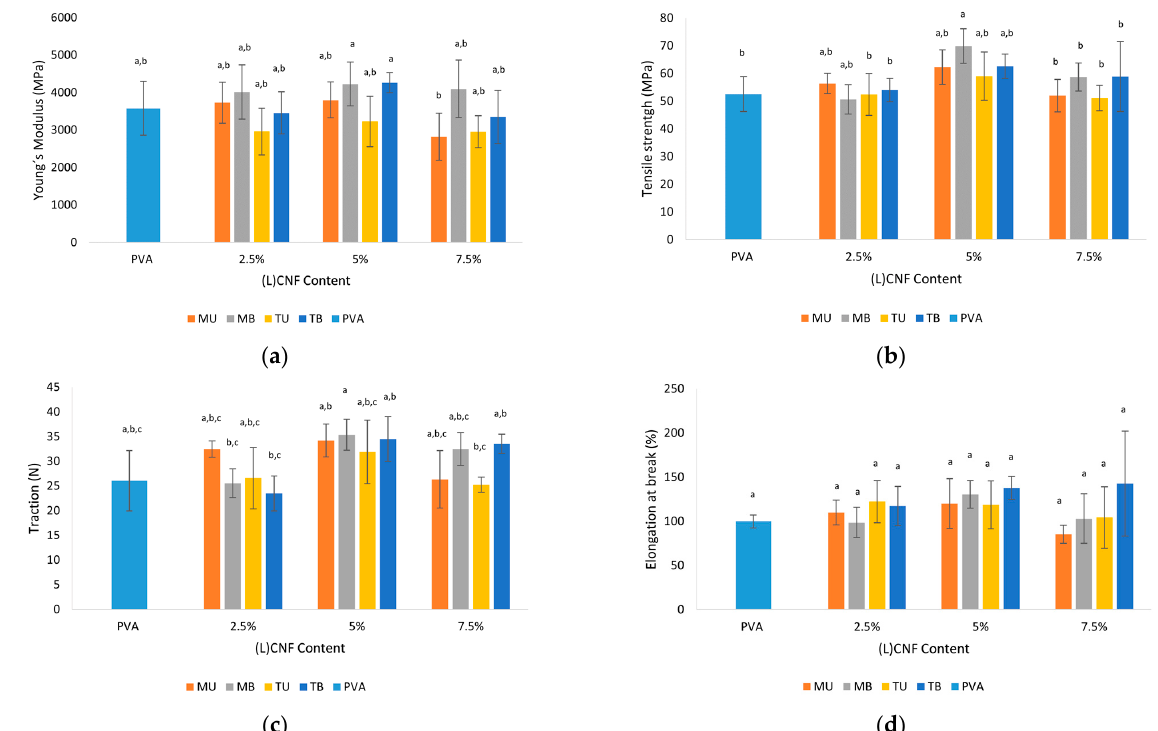
Figure 6. Mechanical properties of pure PVA and PVA-(L)CNF films. ( a ) Young’s modulus; ( b ) tensile strength; ( c ) traction and ( d ) elongation at break. Different letters above the bars represent groups significantly different at p < 0.05.